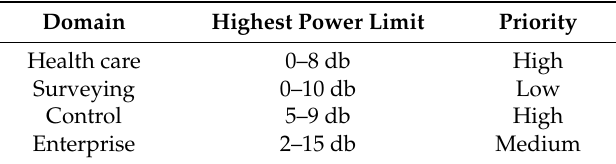
Figure 3. Flowchart of TCA algorithm. Table 3. QoS power